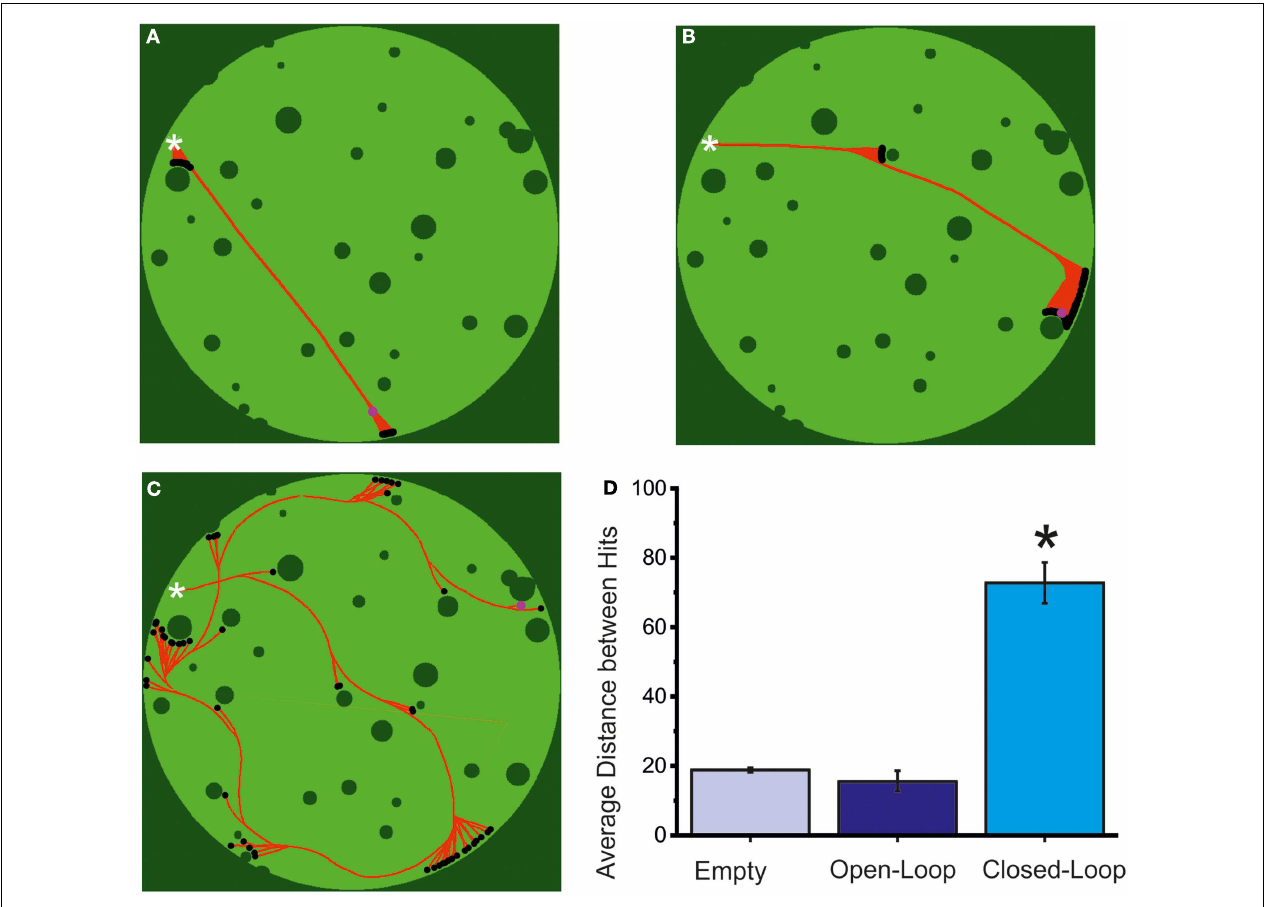
previous case, lacking any capability of navigating its environment. Changes in robot direction are, in this case, provoked by the spontaneous activity of the neural network. (C) Reconstruction of a 20-min long robot trajectory in closed-loop.While the amount of obstacles hit by the robot shows that control is not perfect, the robot is able to take advantage of sensory information to extricate itself from all the situations encountered in a limited amount of time and hits. (D) Performance of the neuro-controlled robot during an obstacle avoidance task in terms of the mean distance between two consecutive collisions, calculated in pixels. The values are obtained in N = 5 experiments for the empty and the open-loop case and in the N = 17 experiments reported in the text (light blue = empty MEA; blue = open-loop MEA; cyan = closed-loop MEA).The closed-loop experiments give the best results. Statistical analysis was carried out by using one-way ANOVA (* p < 0.05) for normal distributions (Kolmogorov–Smirnov test of normality), while for mean comparison both theTukey and the Bonferroni tests were